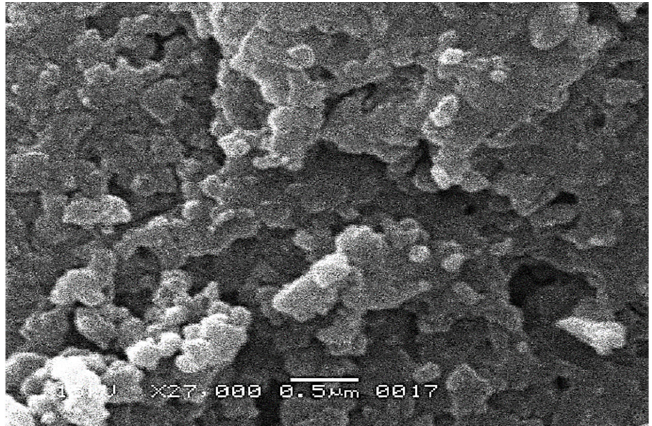
Figure 2. SEM image of the IZNC.